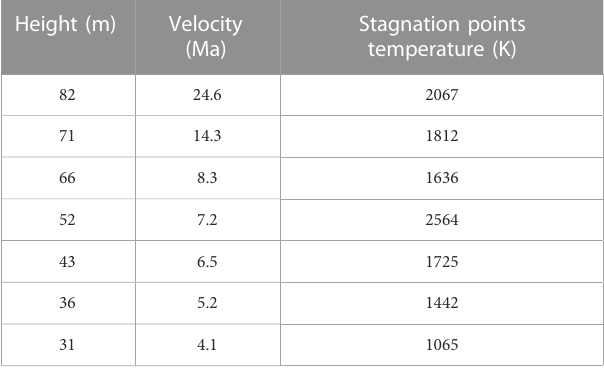
respectively; ρ is atmospheric density; C A is the equivalent resistance area of the recovery system. The fourth-order Runge – Kutta